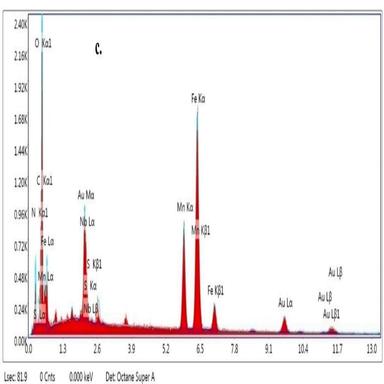
(a, b) SEM micrographs of MnFe2O4/OV,(c)EDAX spectrum of MnFe2O4/OV.